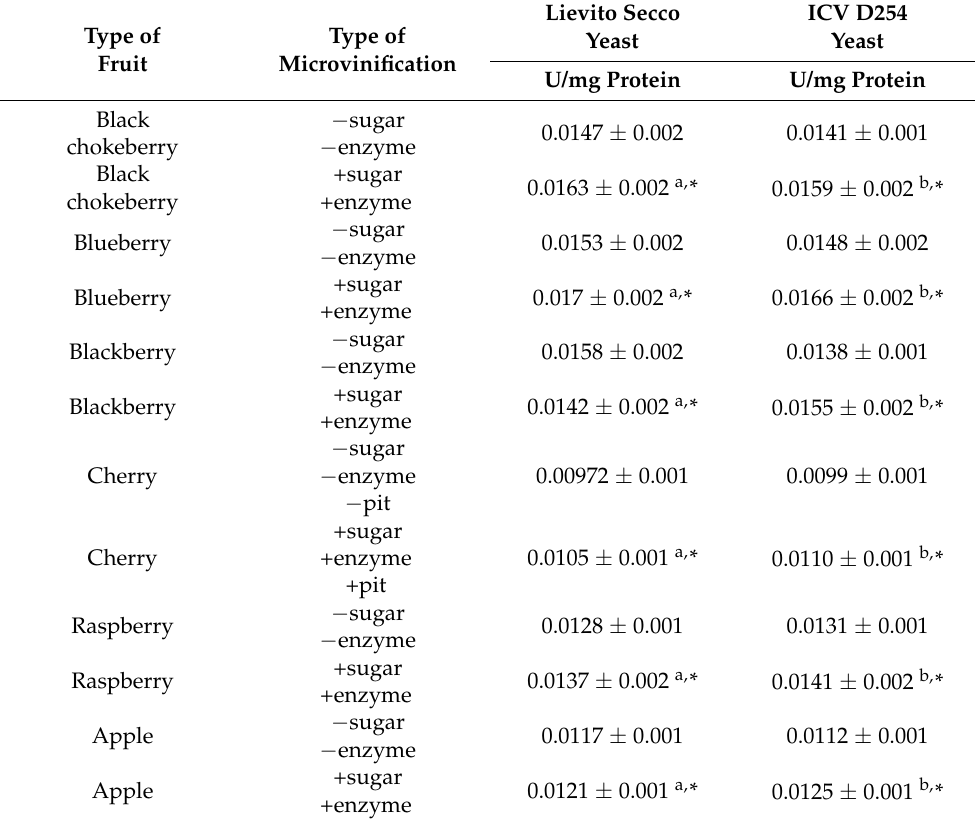
Table 3. Specific activities of GPx (U/mg protein) in fruit wine-treated synaptosomes with H 2 O 2 - induced oxidative stress obtained for different types of fruit wines and